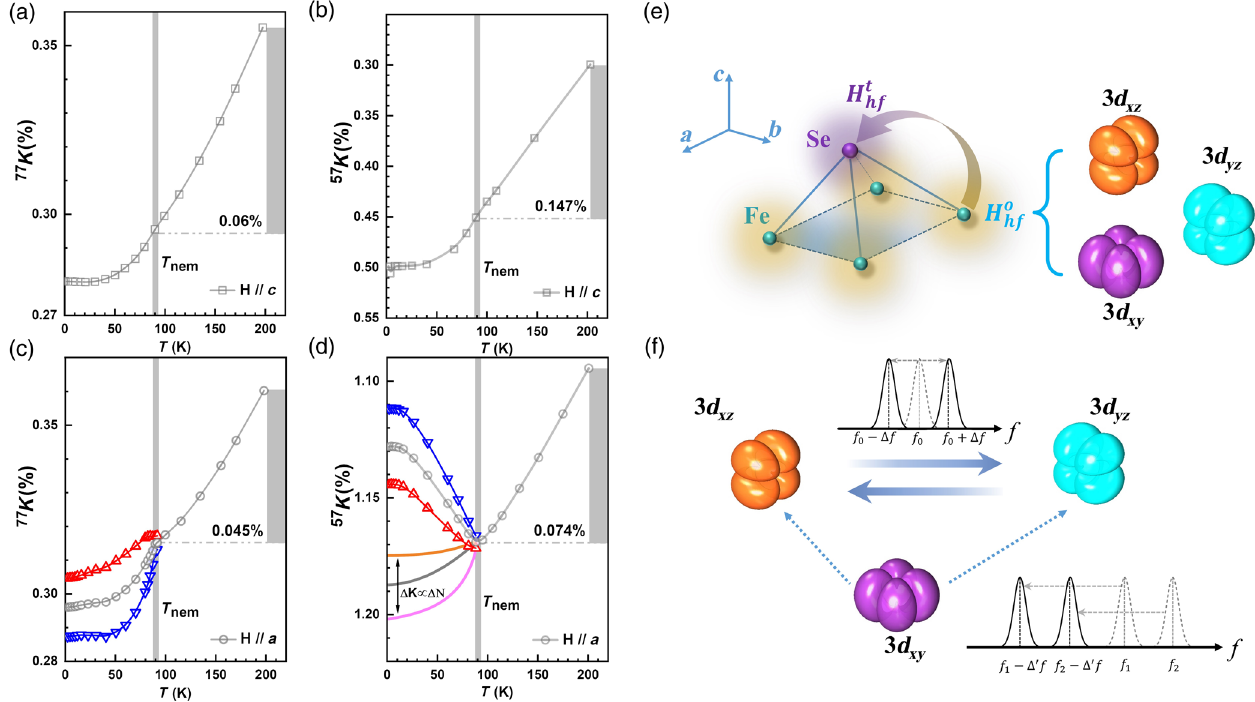
FIG. 2. Knight-shift evidence for orbital-dependent spin susceptibility and orbital order beyond a trivial ferro-orbital picture. (a) – (d) Temperature-dependent 57 Fe and 77 Se NMR Knight shift for H k a and H k c . The red and blue open triangles represent the Knight shifts of the two splitting peaks below T . The open gray circles below T represent the averaged value of the splitting Knight shifts. The nem nem variation of the 57 Fe and 77 Se Knight shifts above T with H k a and H k c are indicated as filled gray rectangles. In panel (d), based on a nem two-orbital model with only 3 d xz and 3 d yz orbitals, the simulated temperature-dependent 57 Fe Knight shifts below T are also depicted nem (see the Methods section in the Supplemental Material for details [39]). The solid orange and magenta curves represent the two splitting Knight shifts. The gray bold line represents the average value of the two splitting Knight shifts. Here, Δ N is the electron population difference between the 3 d xz and 3 d yz orbitals due to the ferro-orbital order. (e) Sketches of the primary hyperfine interactions on 57 Fe and 77 Se nuclei. The hyperfine field on 77 Se is transferred from the Fe 3 d orbitals through the hybridization with the 4 p and 4 s orbitals at the Se sites ( H t hf ). For the 57 Fe nuclei, the dominated hyperfine field is the on-site hyperfine coupling ( H o hf ) (see main text). (f) The role of the 3 d xy orbital on the Knight shift below T . An imbalance distribution of electrons on the 3 d xz and 3 d yz orbitals within a two-orbital nem model will only cause a splitting in the NMR spectra with H k a . When considering the redistribution between the 3 d xy and 3 d xz ( 3 d yz ) orbitals, an overall shift to a lower resonant frequency is